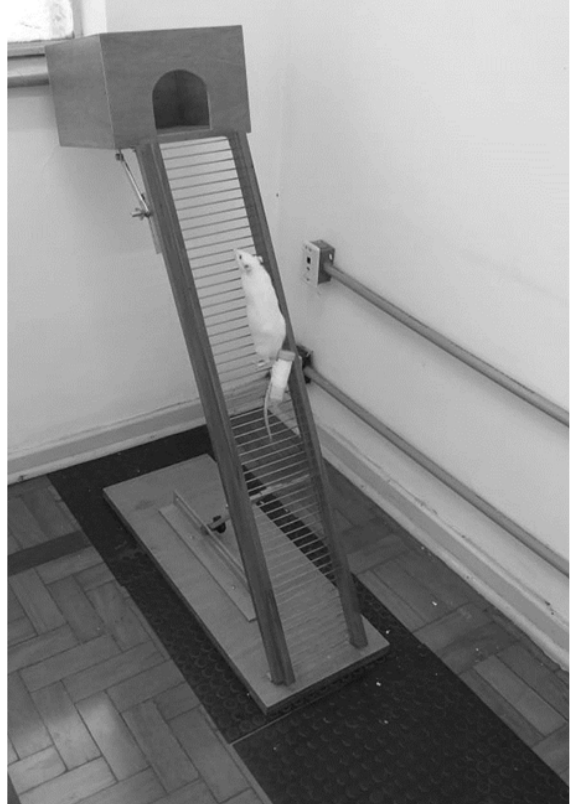
Figure 1. Vertical ladder used for strength training